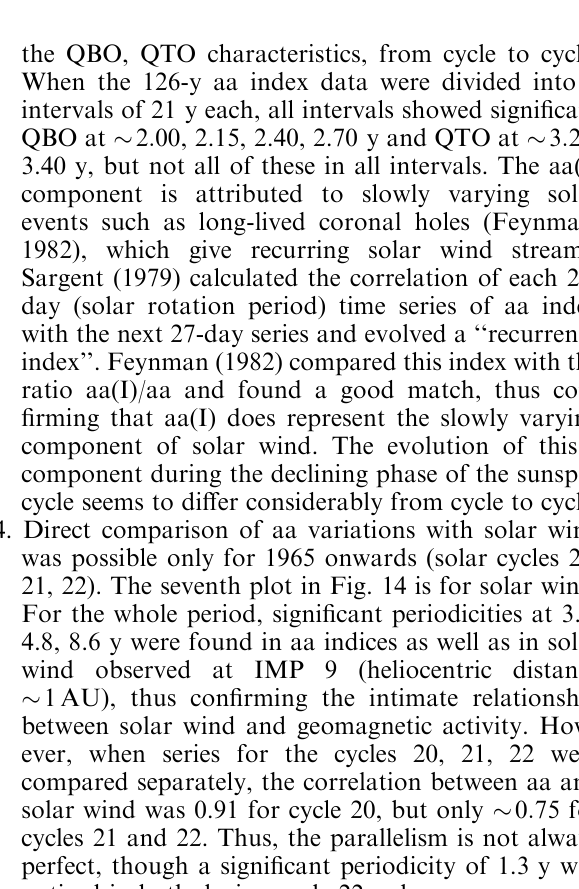
Fig. 14. Plots of sunspot num- bers, aa(12) , aa(39) , aa(12-39) and two aa(I) (present analysis and Feynman) for 1868–1995 (128 years, cycles 11-22) and for solar wind at IMP 8 for